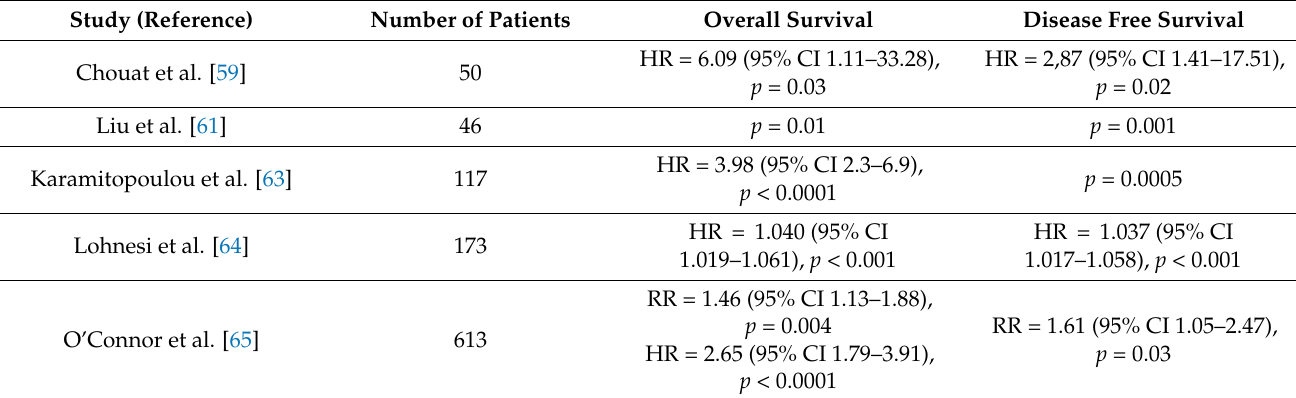
Table 2. Retrospective studies showing a statistically significant association between high grade tumor budding and reduced survival. HR: hazard ratio; RR: relative risk; CI: confidence interval. Study (Reference) Number of Patients Overall